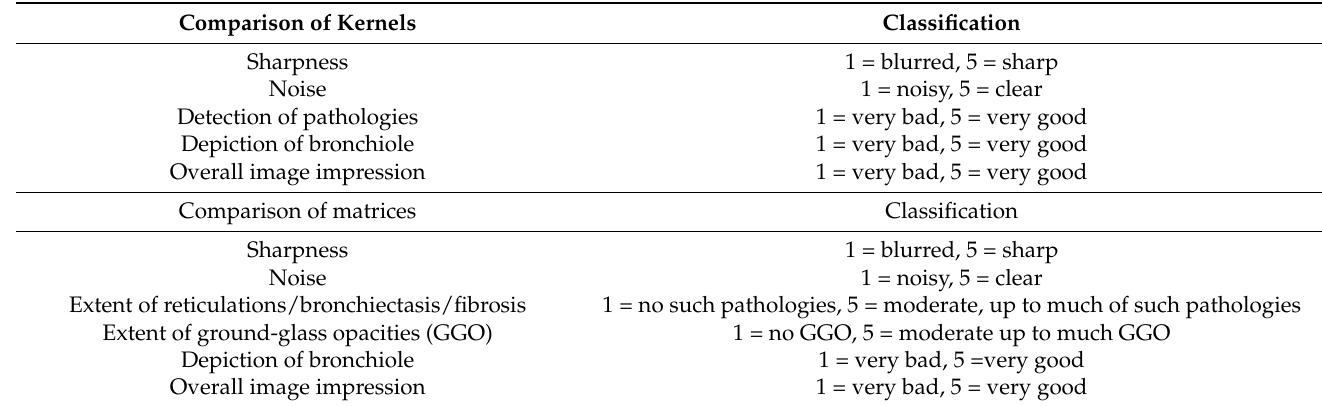
Table 1. Subcriteria for the comparison of kernels and matrices, using a 5-point Likert scale. Comparison of Kernels